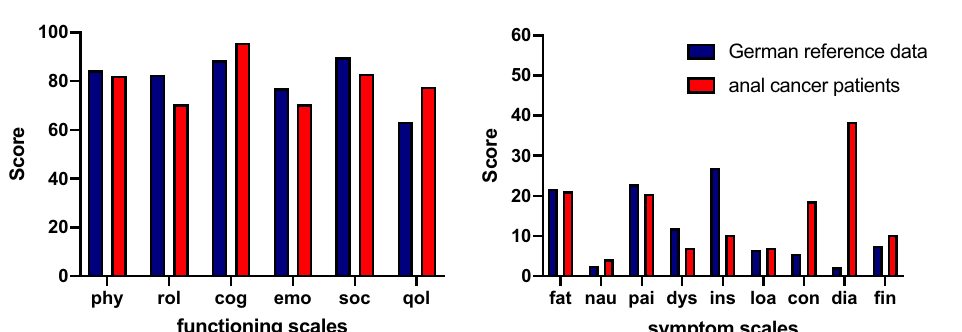
Figure 1. Functioning and symptom scales of the EORTC QLQ-C30 patients vs. German reference population. phy physical function; rol role function, cog cognitive function, emo emotional function, qol global QoL, fat fatigue, nau nausea/vomiting, pai pain, dys dyspnea, ins insomnia, loa loss of appetite, con constipation, dia diarrhea, fin financial